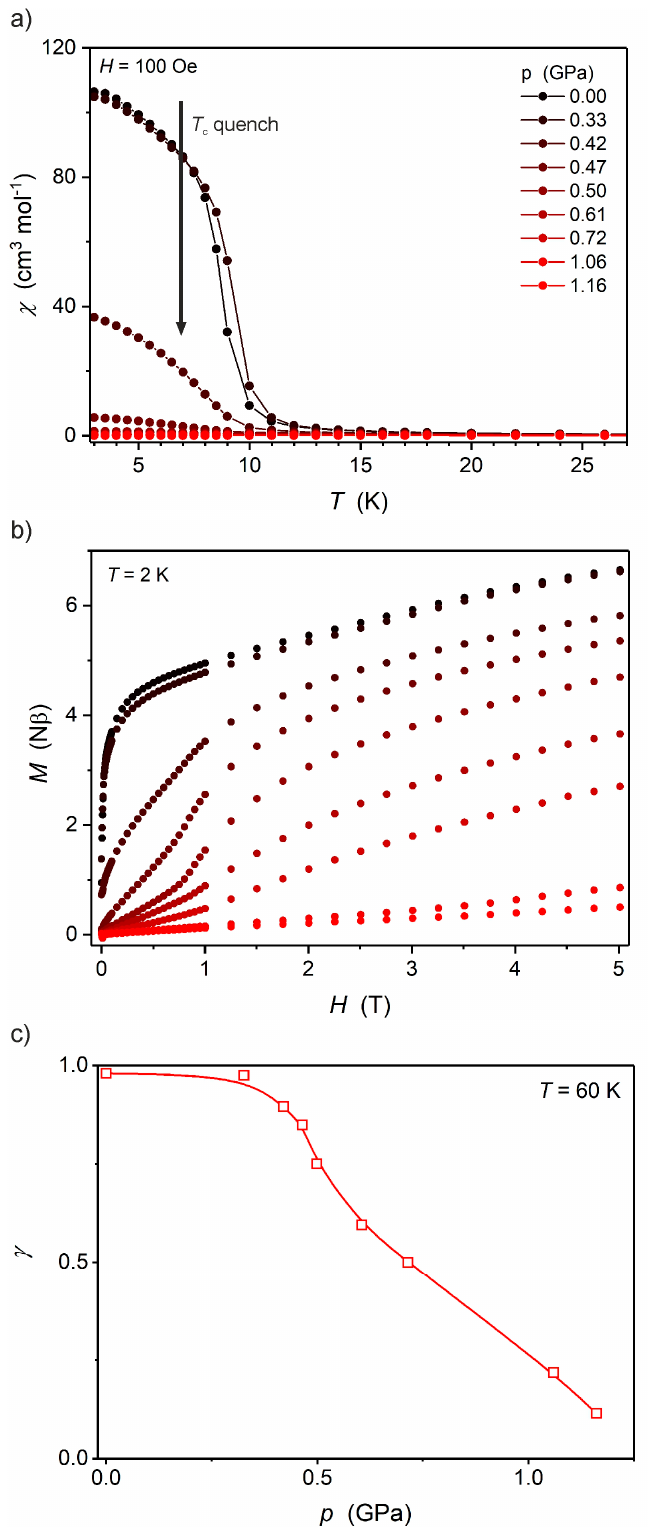
Figure 5. Temperature dependence of molar magnetic susceptibility χ ( T) at 100 Oe ( a ), M ( H ) at 2.0 K ( b ) and fraction of the high-spin Fe II γ ( p ) at 60 K ( c ) for Fe 2 Nb under high pressure. The solid lines in (a,c) are only guides for the eye.